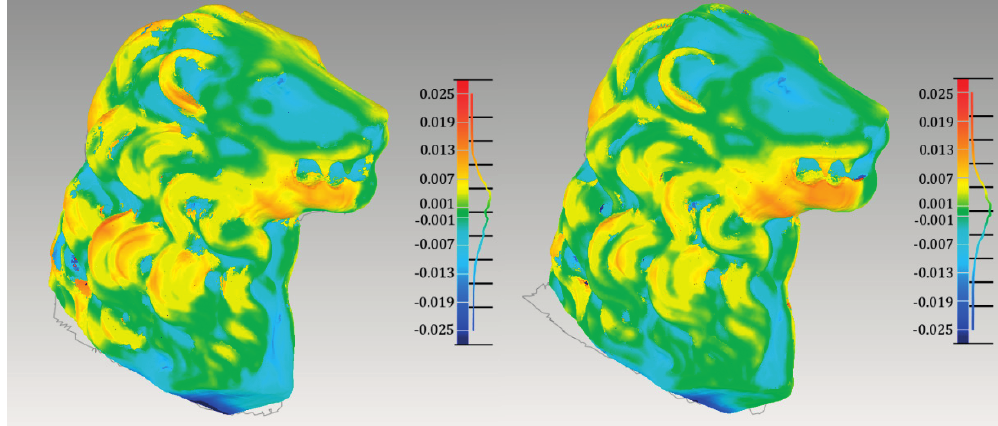
Figure 14. 3D comparison (shortest differences) between the reference model and the Kinect Fusion mesh ( left ) and the Fusion model with the IO parameters correction ( right